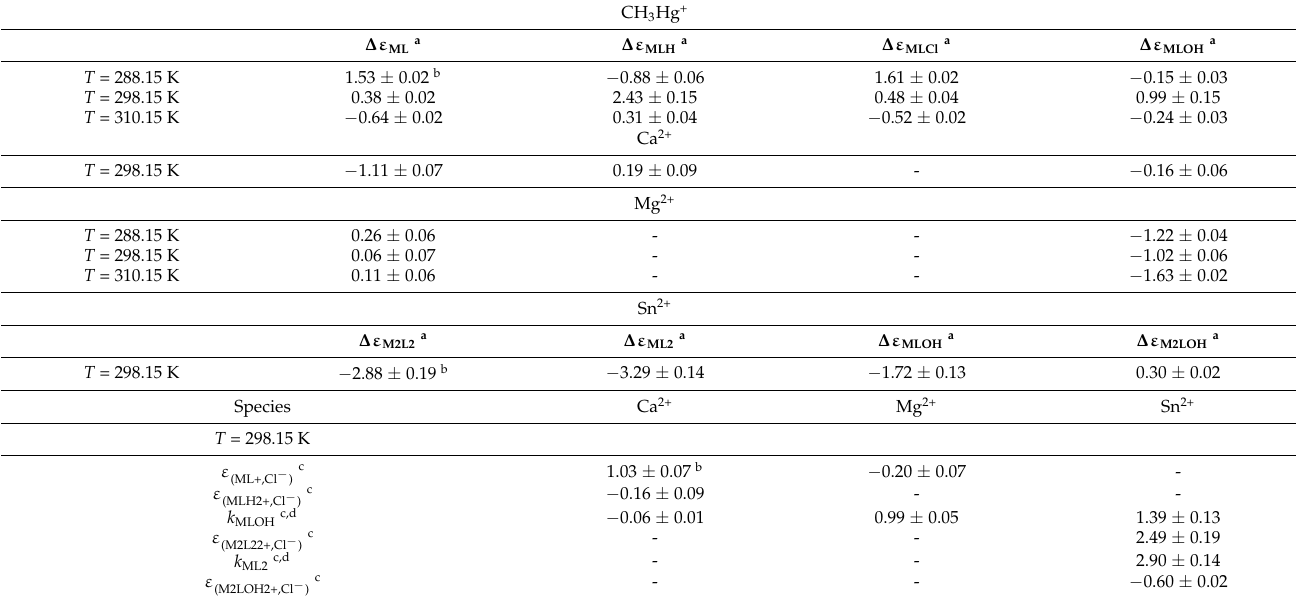
Table 10. Specific ion interaction parameters and Setschenow coefficients for the species of the metal/dopamine systems. CH 3 Hg